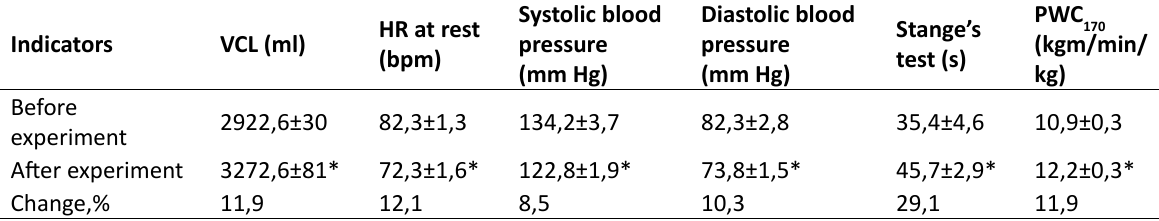
Table 3. Dynamics of women functional condition indicators ( X ±m)